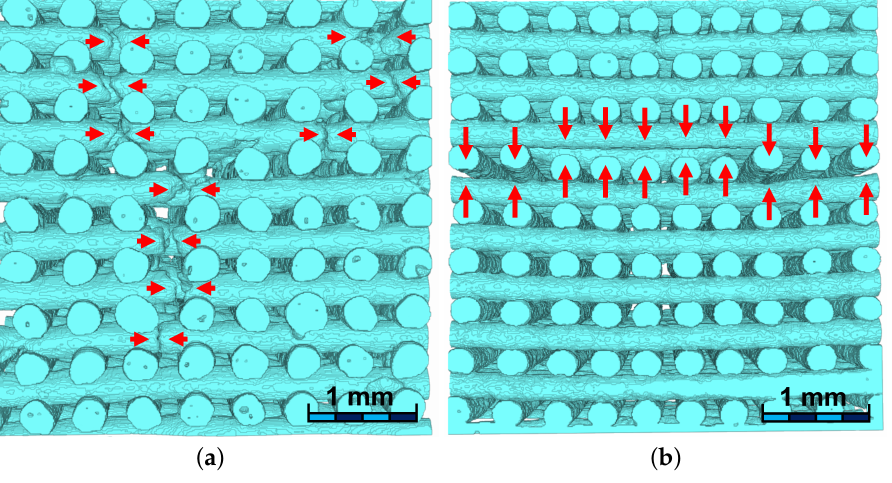
Figure 1. Micro-CT reconstruction of two scaffolds. Geometric imperfections are described: ( a ) fibers interruption identified by red arrows and ( b ) fibers detaching between two adjacent printing planes.